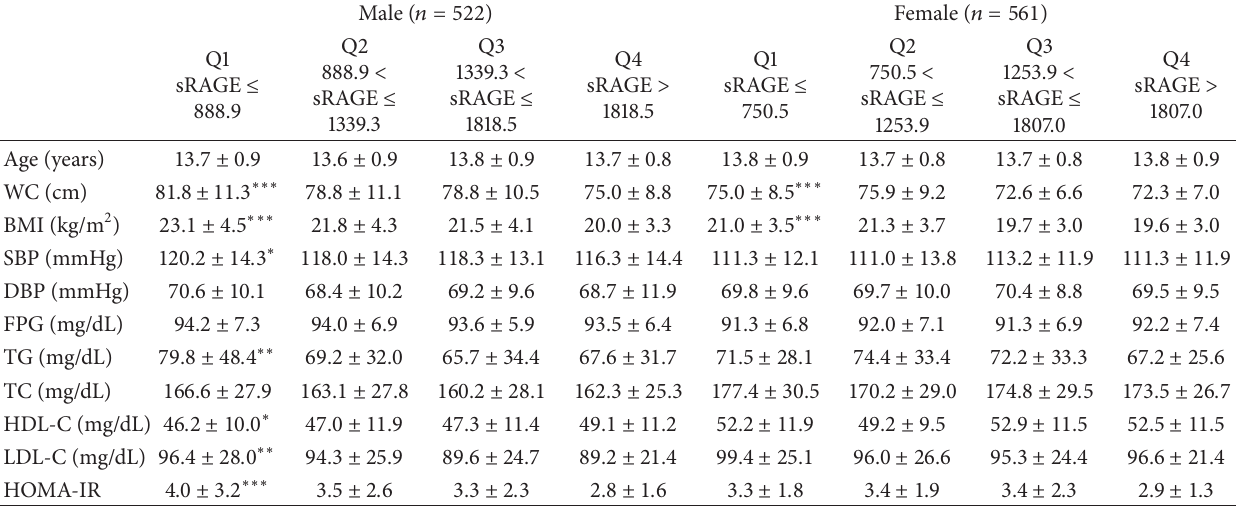
Table 2: Clinical and anthropometric parameters by different sRAGE categories.